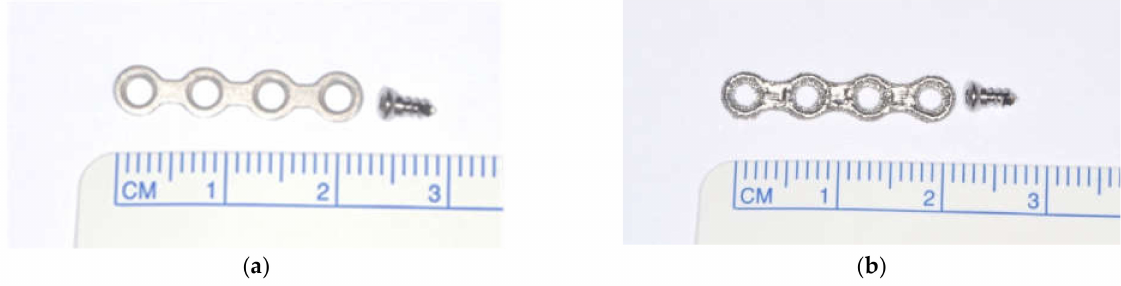
Figure 3. Titanium implant and screw use in the study: ( a ) milled titanium implant and ( b ) DMLS titanium